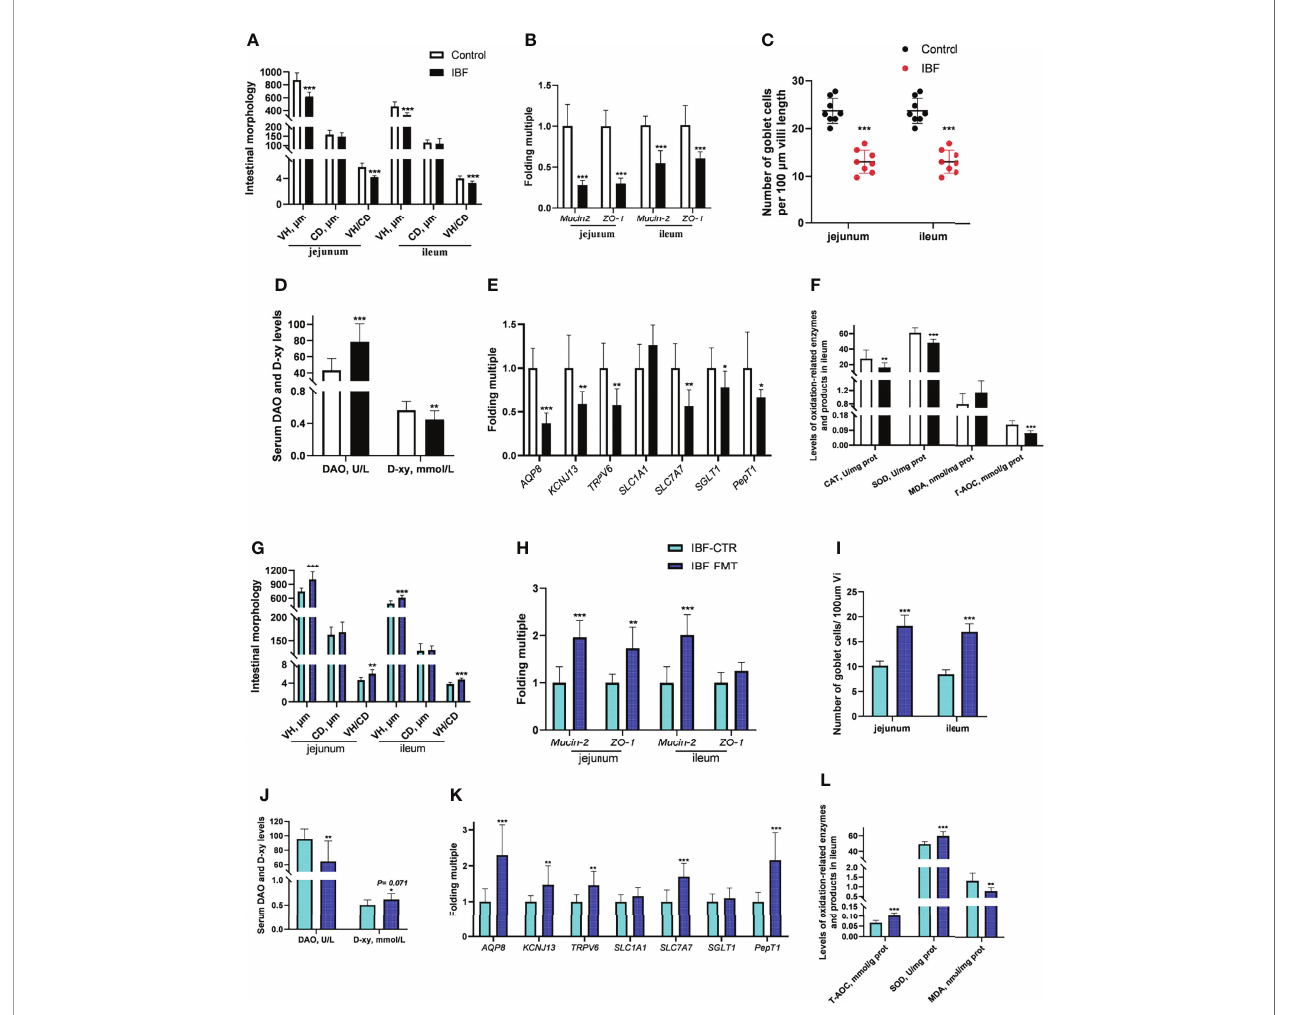
FIGURE 2 | Effects of FMT on intestinal barrier, absorption and antioxidant function in IBF chickens. The results of the comparative study of control and IBF chickens were shown in panels (A – F) [as to panels (A – C) , n= 8. Additionally, panels (D – F) , n= 10], and the comparison results between IBF-CTR and IBF-FMT chickens were shown in panels (G – L) (n= 8). Among them, VH= villi height, CD= crypt depth, VH/CD= the ratio of VH to CD, DAO= diamine oxidase, D-xy= D-xylose, CAT= catalase, SOD= superoxide dismutase, MDA= malondialdehyde, and T-AOC= total antioxidant capacity. Additionally, *means that the data tends to be different (0.05< P < 0.1), **represents a signi fi cant difference (0.001< P < 0.05), and ***represents an extremely signi fi cant difference ( P < 0.001), the same